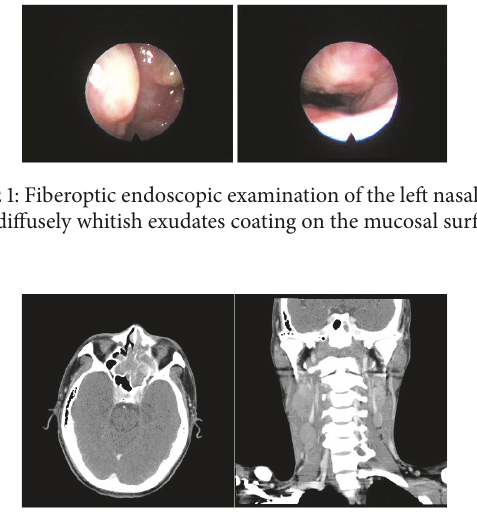
lymph node and punch biopsy of the nasal mucosa were